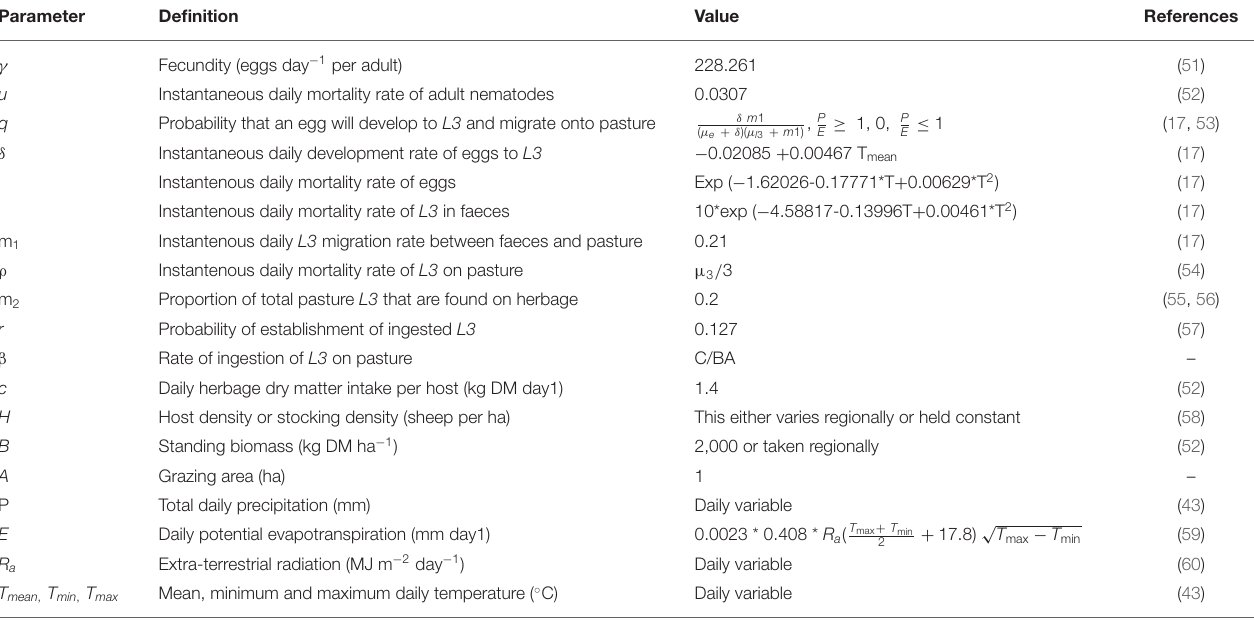
TABLE 2 | Extended Q 0 model parameter definitions and estimates, based on values for Teladorsagia circumcincta ; and within-host stages in sheep. Parameter